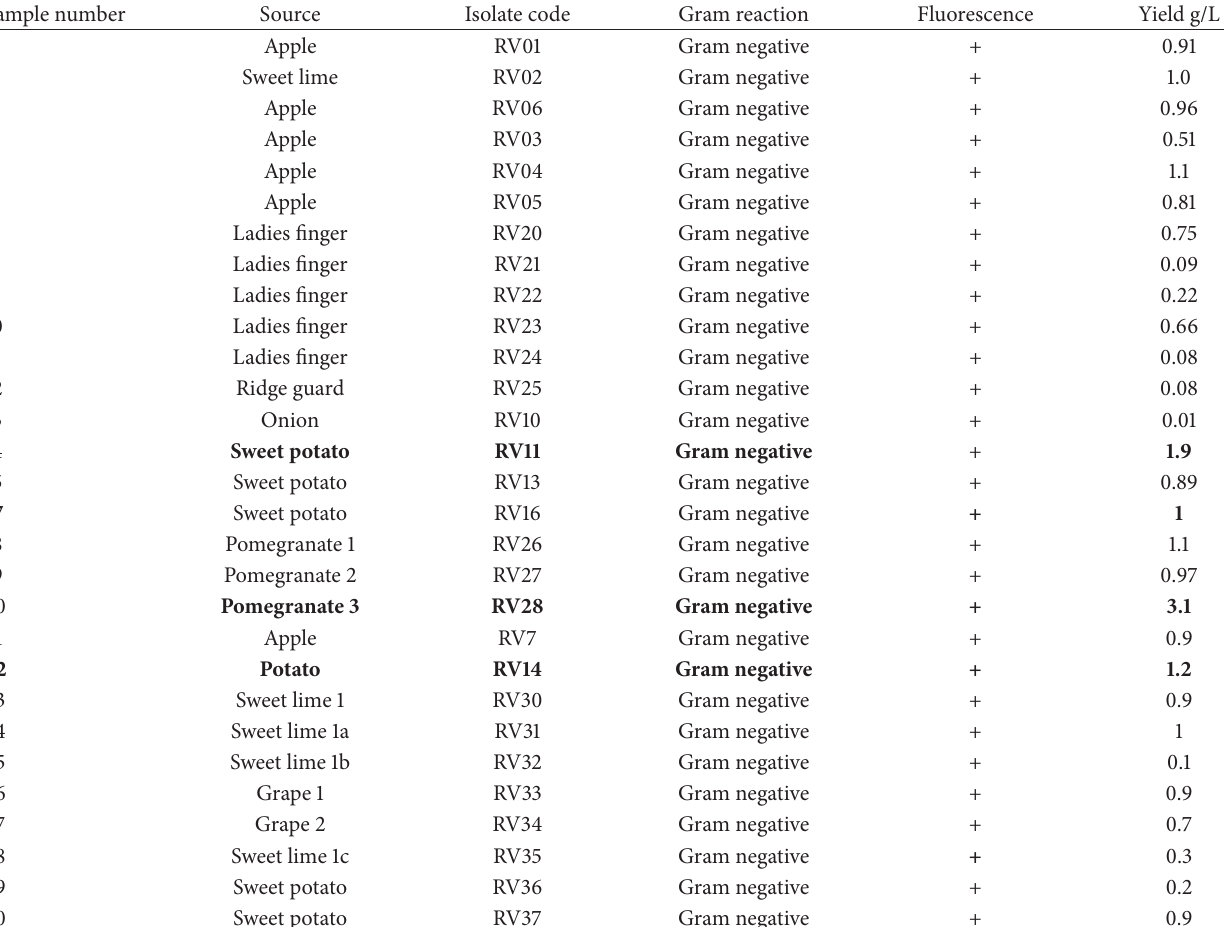
Table 4: Screening of isolates for cellulose production (yield in